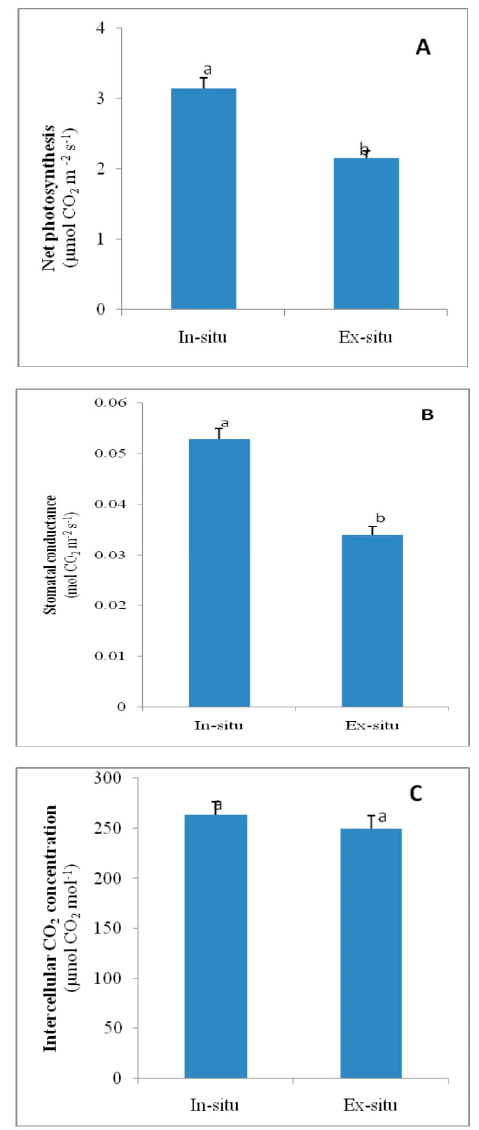
Figure 3. Photosynthesis ( A ), stomatal conductance ( B ), and intercellular CO 2 concentration ( C ) of in-situ and ex-situ grown plants of Valeriana wallichii . Data are presented as treatments mean ± SE ( n = 5). SE = standard error; n = number of samples. The mean di ff erence of in-situ from ex-situ was considered statistically significant at p < 0.05 (using Student’s t -test). Data followed by the same letter are not significantly different.